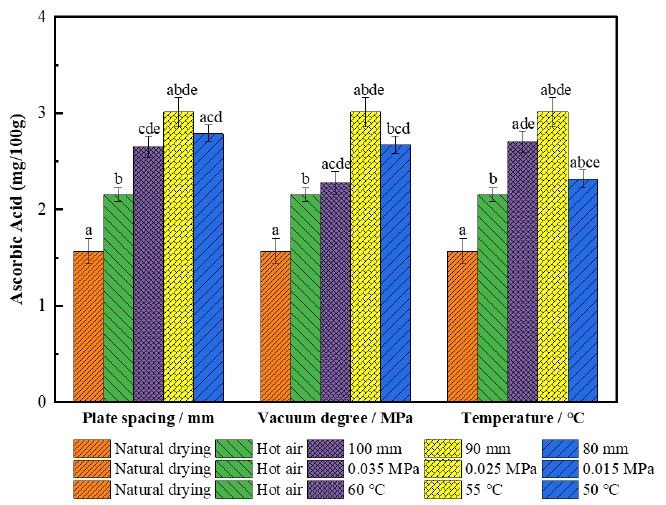
Figure 9. Ascorbic acid content of L. barbarum under different drying conditions. Significant differ- ences are represented by different letters ( p < 0.05).